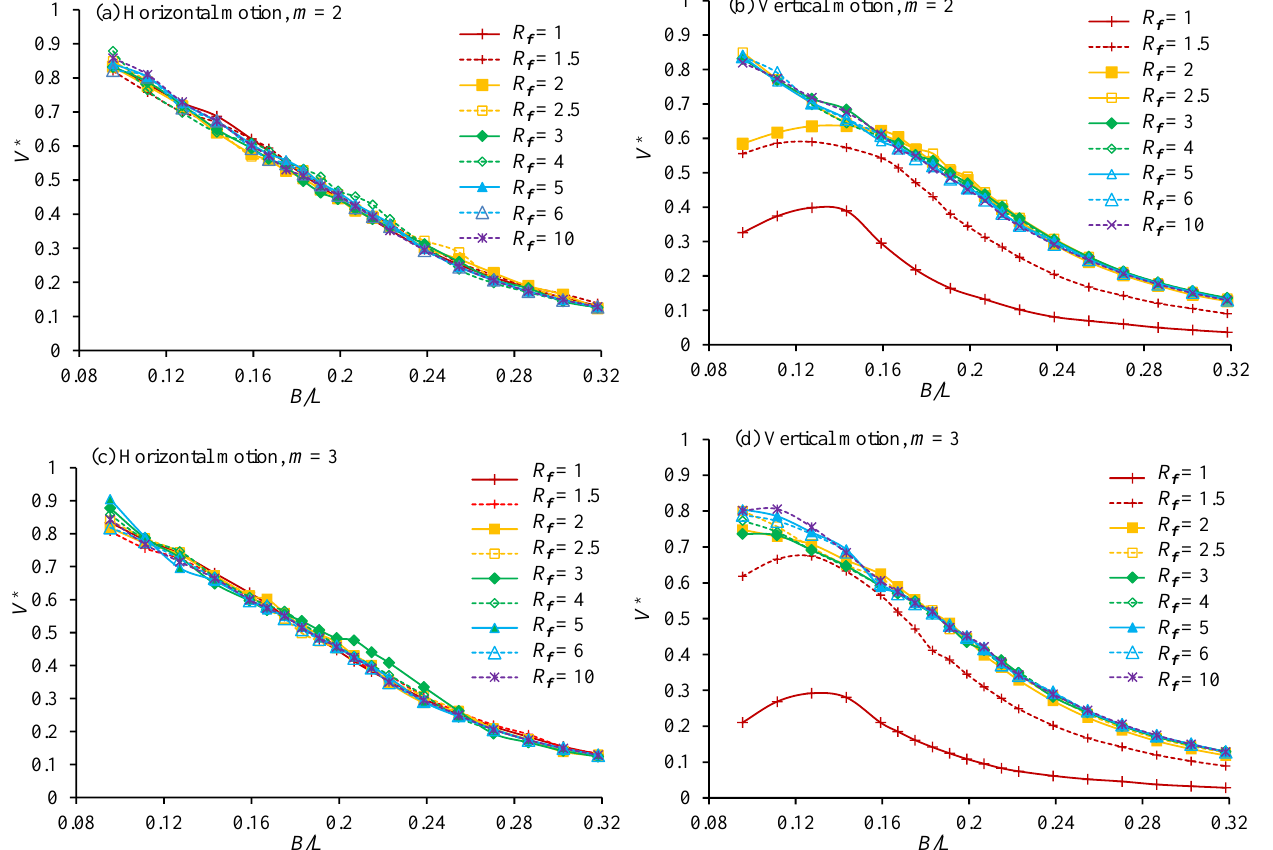
Figure 5. Variation of the amplitude of oscillatory air volume of the floating OWC chamber with B / L for K t = 3000 Pa·m −3 ·s and various frequency ratios at d / h = 0.25. From the explanation above, it is further established that a mounting system’s natural frequency must be sufficiently high to provide high efficiency for the vertical motion. When the OWC moves vertically with a very soft mounting system, the OWC motion and wave surface elevation have big amplitudes, but the efficiency is low. However, the horizontal motion shows opposite results, and a soft mounting system (small R f ) provides a slightly higher efficiency as shown in Figure